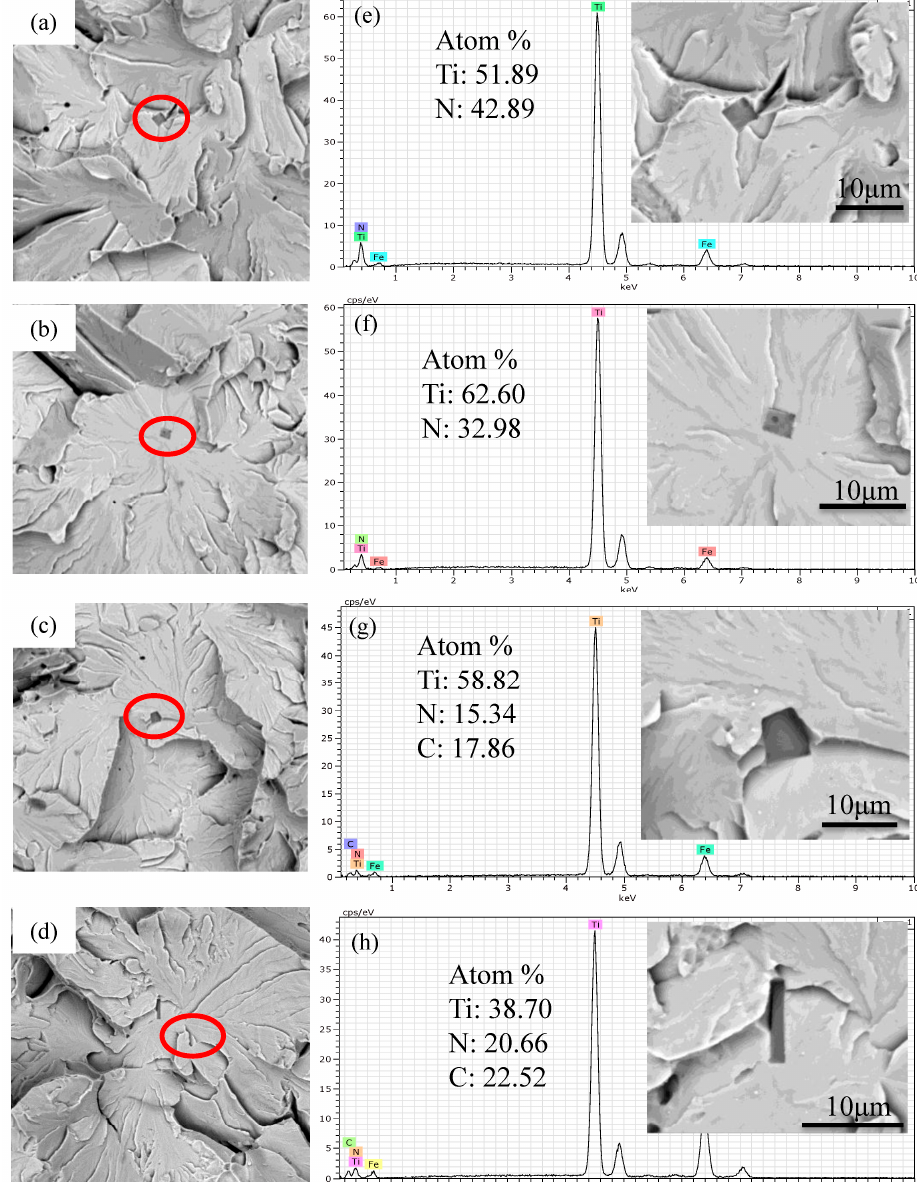
Figure 2. ( a – d ) SEM images of coarse Ti(C, N) particles found at initiation sites for brittle fractured sample steel 1; ( e – h ) higher magnification images of the red ellipse and the composition of Ti(C, N) particles in ( a – d ),